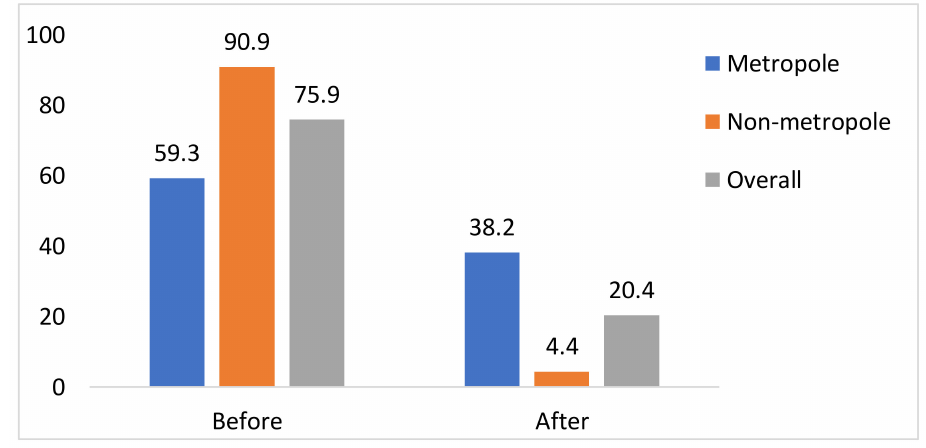
Figure 1. Intention to receive the HPV vaccination before / after knowing the price ( n =